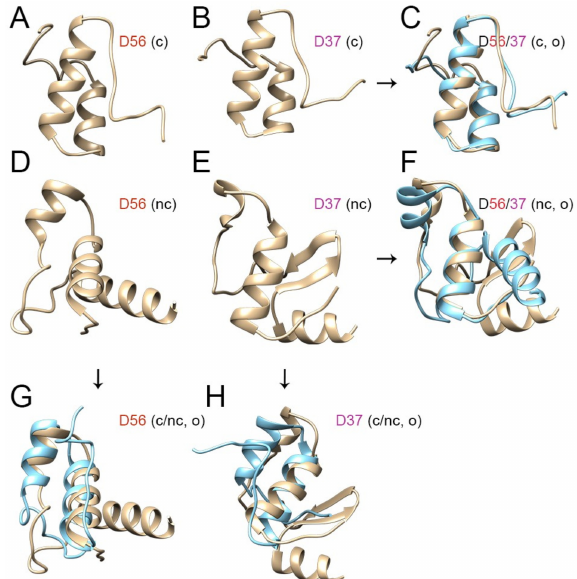
Figure 4. Ab initio protein structure model comparisons for E1A CR3 for HAdV-D56 and D37. The canonical (c) 46 amino acid CR3 regions for ( A ) D56 and ( B ) D37 appear very similar ( C ) when overlapped (o) (D56 in tan color and D37 in cyan). The full-length, noncanonical (nc) 62 amino acid sequences for ( D ) D56 and ( E ) D37 are more disparate ( F ). Overlapped comparison of the 46 and 62 amino acid-based models for D56 ( G ) shows relatively little difference in the structure of the zinc finger domain for D56, but a significant change in conformation of the putative zinc finger domain for D37 ( H